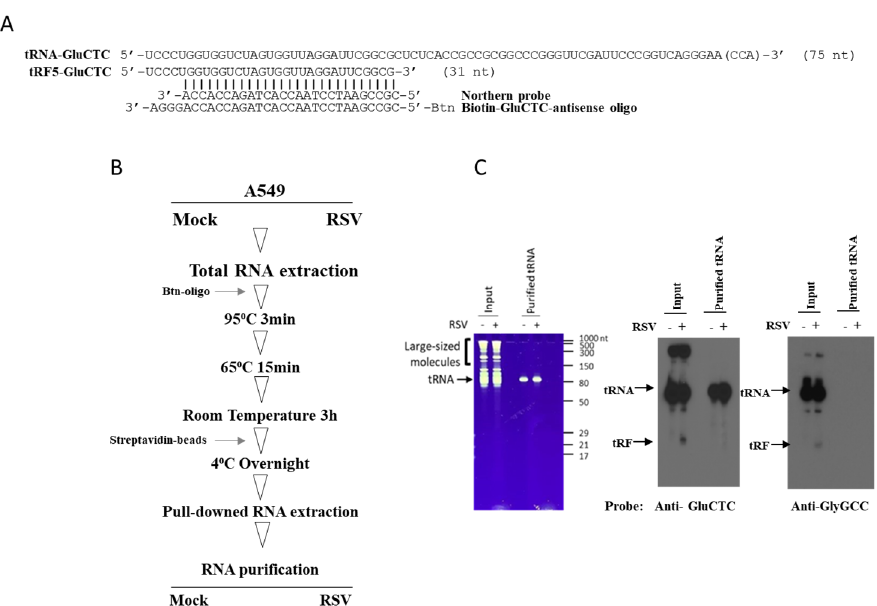
Figure 2. The schematic summaries on tRNA-GluCTC preparation. ( A ) Sequencing information on tRF5-GluCTC and its parent tRNA, the antisense probe used to detect tRNA by Northern blot, and biotinylated antisense oligo to pull down tRNA-GluCTC. ( B ) The workflow to purify tRNA- GluCTC. ( C ) The input and purified tRNA-GluCTC from mock- and RSV-infected cells. Left panel: SYBR TM Green II RNA staining of total RNAs for mock- and RSV-infected cells (left two lanes) and enriched tRNAs (right two lanes). Middle panel: input RNAs and enriched tRNAs were detected by antisense oligo against tRNA-GluCTC. Right panel: input RNAs and enriched tRNAs were detected by antisense against tRNA-GlyGCC.